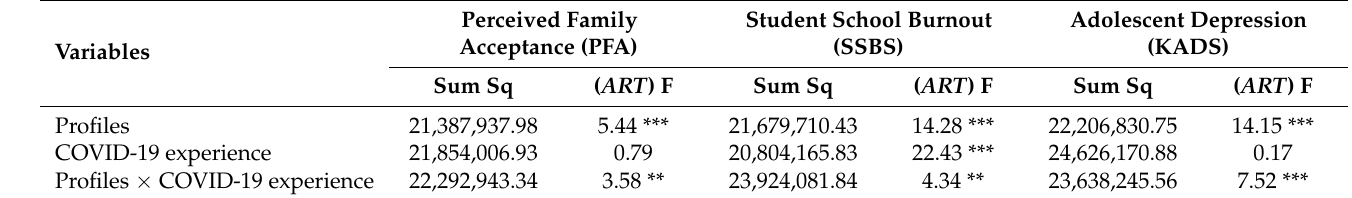
Table 5. Aligned rank transformation ANOVA of the interaction effect of profiles and COVID-19 experience for main psychological measurements: Perceived family acceptance (PFA), student school burnout (SSBS), and adolescent depression (KADS) ( N =